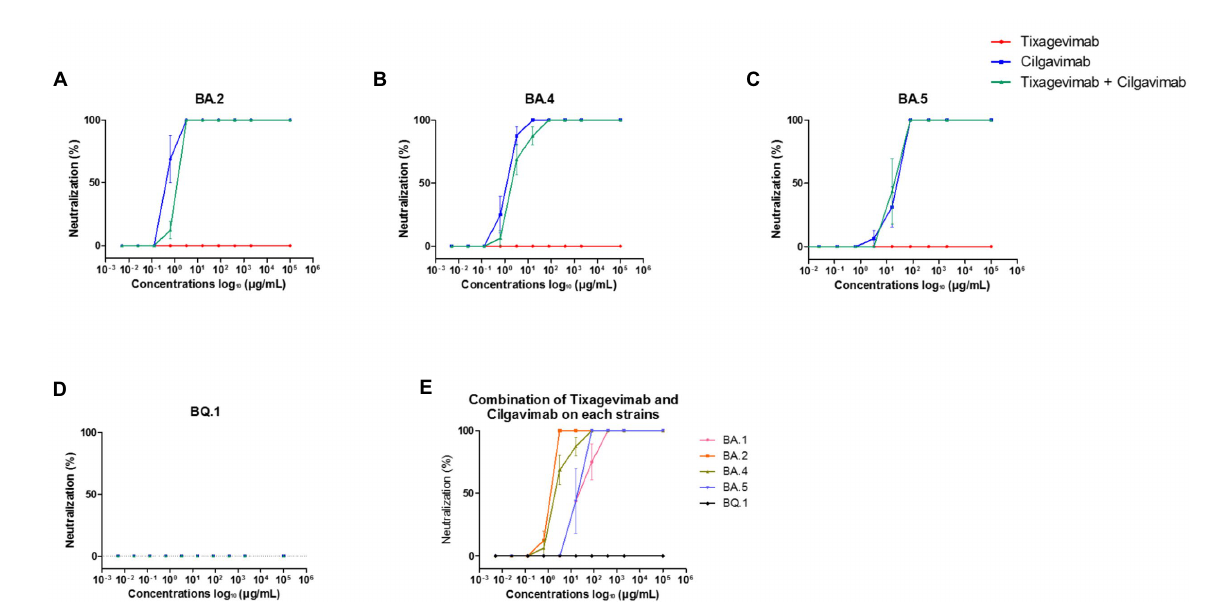
FIGURE 8 Neutralization curves for Omicron BA.2, BA.4, BA.5, and BQ.1 tested with monoclonal antibodies. (A) Omicron BA.2 tested with tixagevimab, cilgavimab, and a combination of both. (B) Omicron BA.4 tested with tixagevimab, cilgavimab, and a combination of both (C) Omicron BA.5 tested with tixagevimab, cilgavimab, and a combination of both. (D) Omicron BQ.1 tested with tixagevimab, cilgavimab, and a combination of both. (E) Comparison of each Omicron isolate tested with the tixagevimab/cilgavimab combination; BA.1 was considered as a control. Each experiment was performed four times. Bars represent the standard